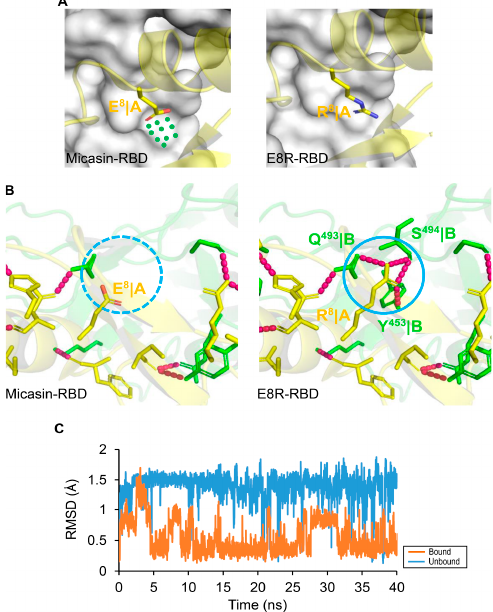
Figure 5. Structure − based design of micasin mutants by targeting the unoccupied surface on RBD. ( A ) The micasin − RBD complex with Glu − 8 side − chain shown ( left ). The underutilized cavity by Glu − 8 is represented by dots in green. The E8R − RBD complex with Arg − 8 side − chain shown ( right ). In these two complexes, peptides are displayed as cartoon model and RBD as molecular surface model. ( B ) Comparison of the two complexes highlighting the side − chain extension from Glu to Arg leading to four new hydrogen bonds between E8R and RBD. ( C ) Side − chain dynamics of Arg − 8. The RMSD of Arg − 8 extracted from a 40 − ns MD simulations with respect to the bound and unbound conformation along the MD trajectory. The RMSD is in reference to the original minimized